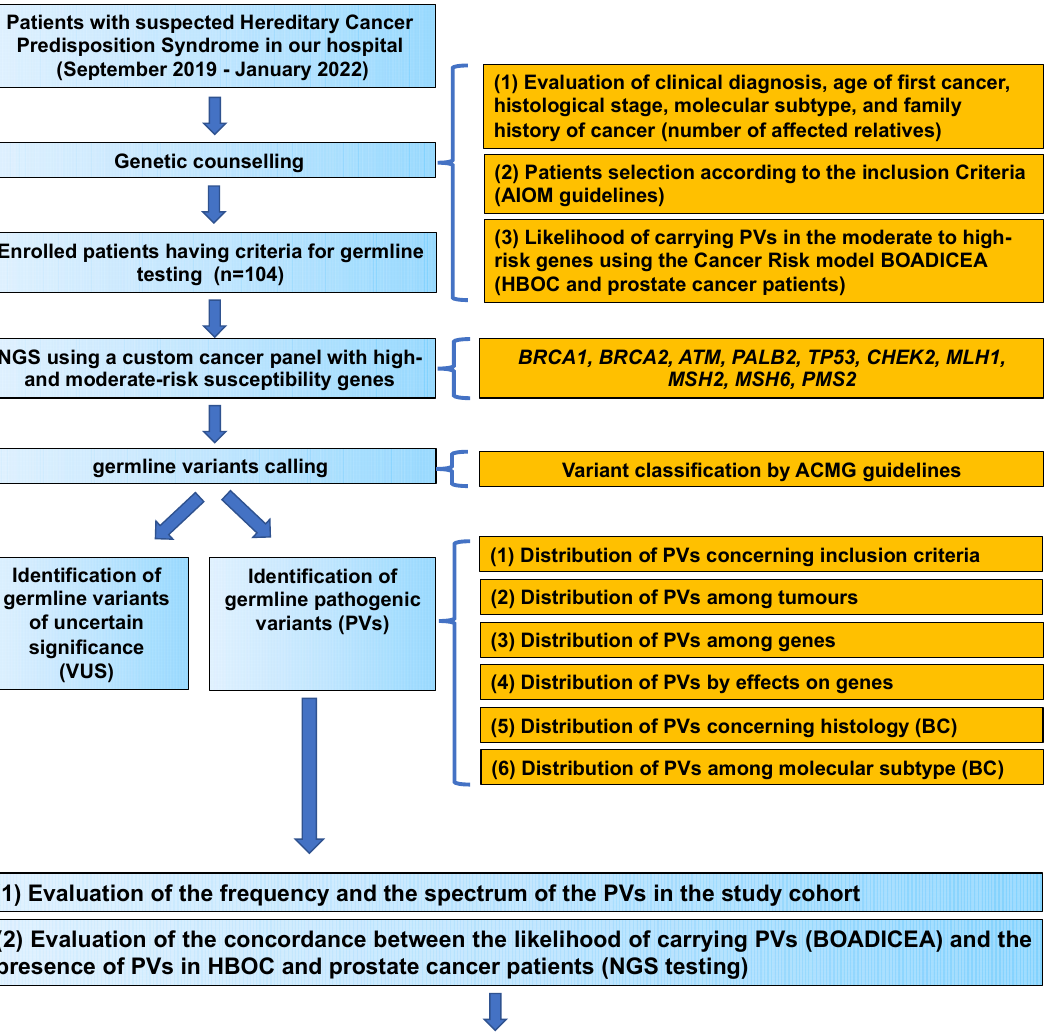
Figure 1. Study flow chart. PVs, pathogenic variants; VUS, variants of uncertain significance; BC, breast cancer; HBOC, hereditary breast and ovarian cancer